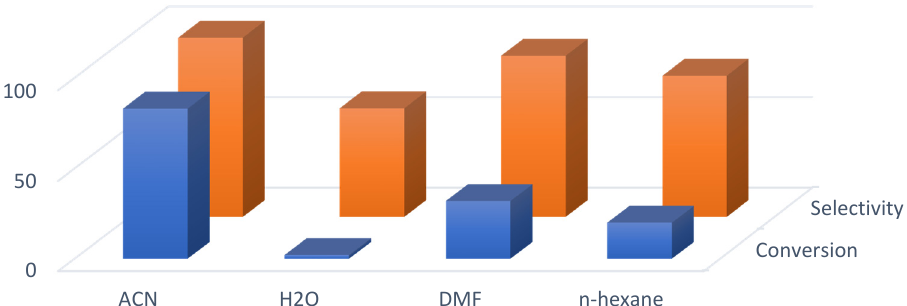
Figure 10. Optimization of the reaction parameters for the oxidation of VAL to VN with respect to the solvent type. Reaction conditions: 1 mmol vanillyl alcohol, 0.4 mol.% NiFe 2 O 4 , air, rt, 10 mL solvent, 0.8 mol.% TEMPO, base 2 equiv., and 6 h reaction time. Conversion was determined by GC analysis using 1,2-dichlorobenzene as the internal standard.